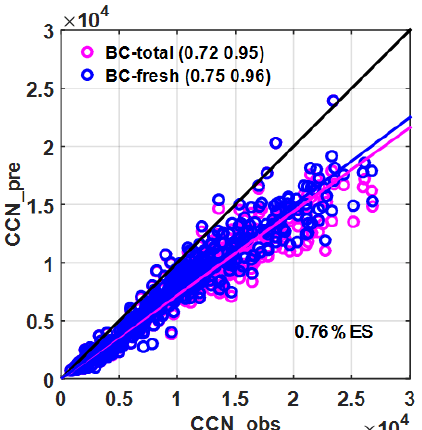
Figure 7. Predicted N CCN as a function of measured N CCN us- ing the EXT–SR (ES) assumption (colored symbols) at S = 0.76%. The pink and blue circles denote the results predicted using total and fresh BC size distributions, respectively. The numbers in paren- theses are the slope (first number) and the correlation coefficient (second